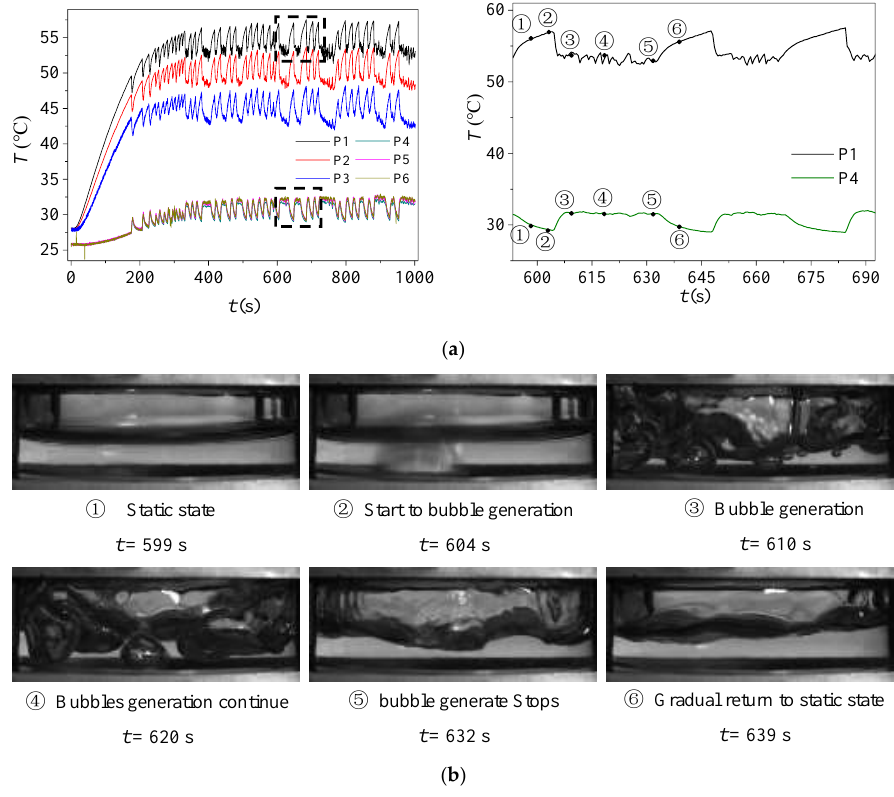
Figure 8. Alternate pulsation state (State B–1, φ = 47%, q = 10.9 W/cm 2 ): ( a ) temperature dynamic variation of evaporator wall; ( b ) gas–liquid two-phase behavior in one cycle.